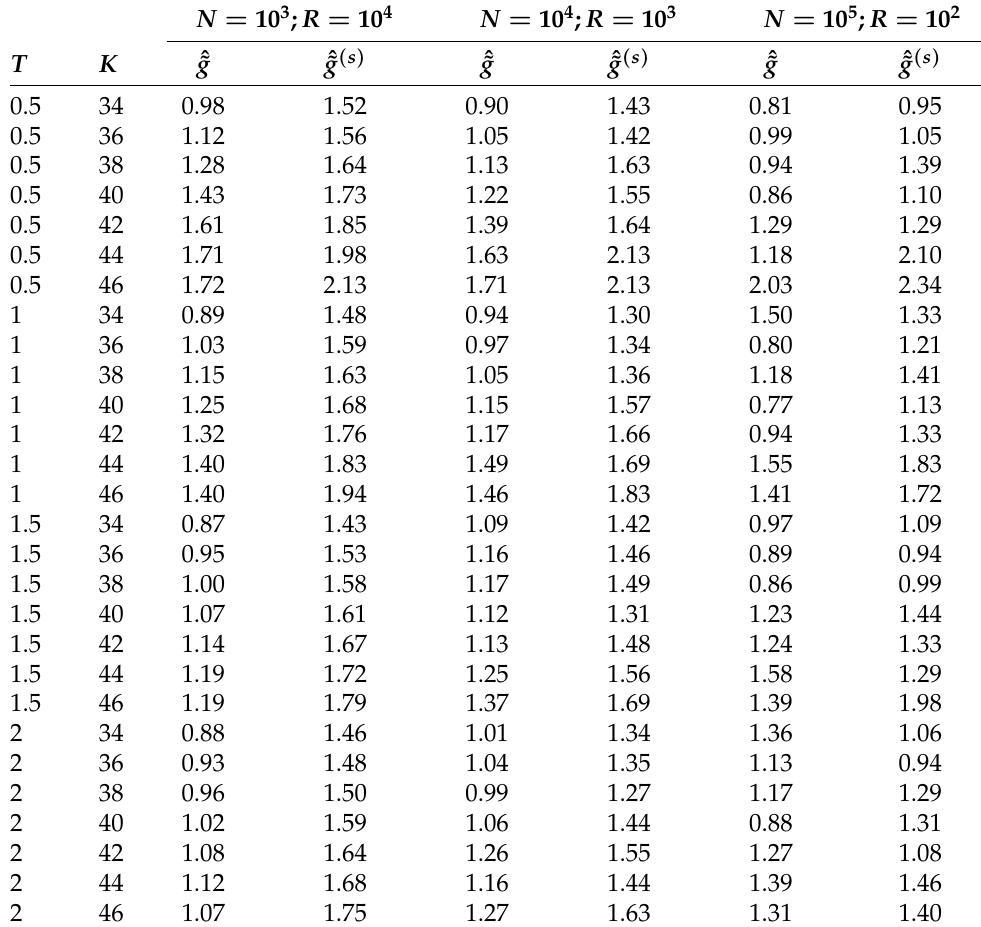
Table A5. Detailed RMSE efficiency results with optimized drift.